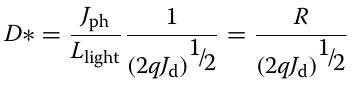
Fig. 2 Comparison of a XRD patterns of CsPbI 2 Br films, b XRD patterns of CsPbIBr 2, c absorption of CsPbI x Br 3 CsPbI x Br 3 with or without DE − x